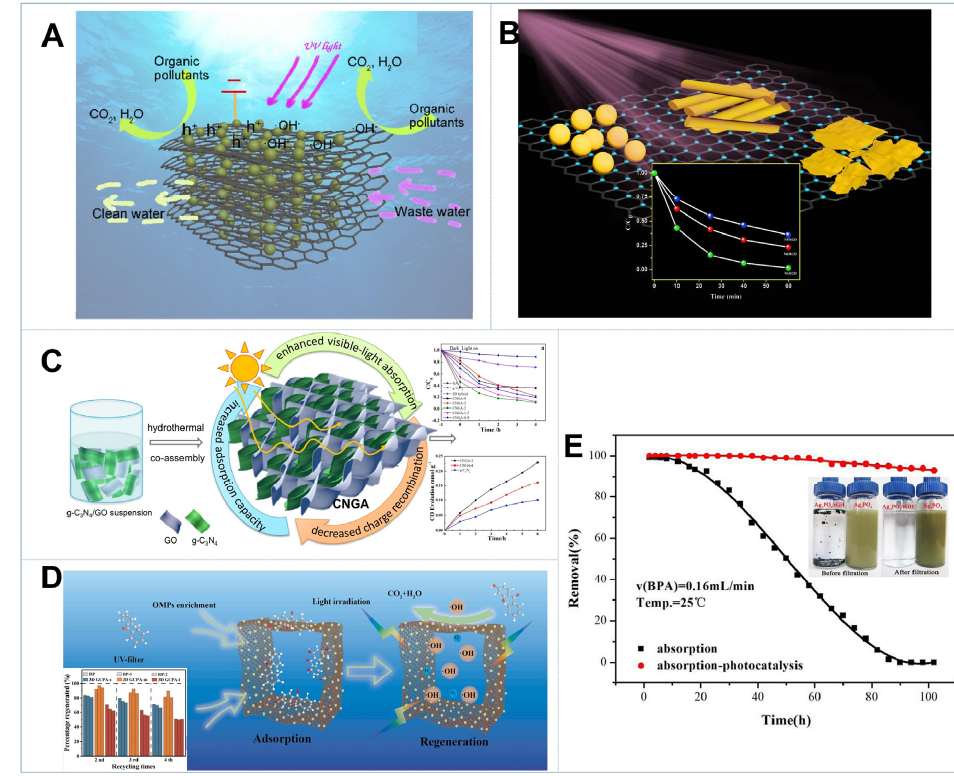
Figure 5. ( A ) Schematic illustration of the possible photoelectrocatalytic mechanism [136]. ( B ) Photocatalytic degradation of MB by different CdS/RGO composites [138]. ( C ) Synthesis of g- C 3 N 4 /GO aerogels (CNGA) and photocatalytic degradation of MO under visible light [139]. ( D ) 3D GCPA-m in OMPs removal and its reusability [147]. ( E ) Breakthrough curves of adsorption and adsorption-photocatalysis of Ag 3 PO 4 /rGH